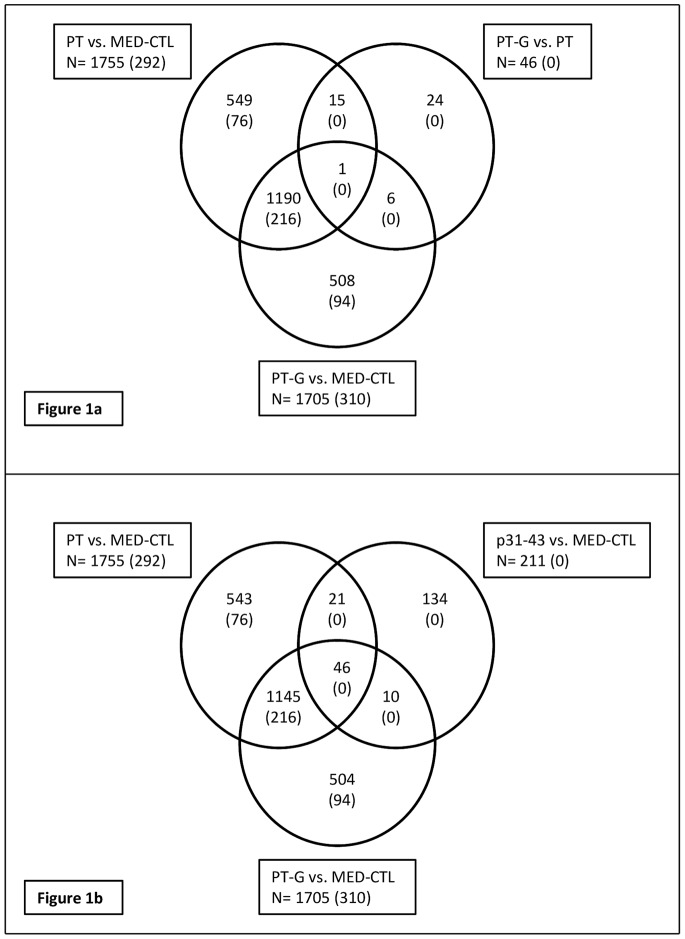
Venn diagrams showing the number of probes differentially expressed in response to pepsin- and trypsin-digested gliadin (PT-G) (Figure 1a) compared to medium control (MED-CTL) and the blank pepsin- and trypsin (PT) control.The probes that were affected by PT treatment compared to MED-CTL are also displayed. Figure 1b shows the probes affected by PT, PT-G and p31-43 peptide compared to MED-CTL. The numbers in parenthesis represent the number of probes obtained after multiple testing correction as described in materials and methods.